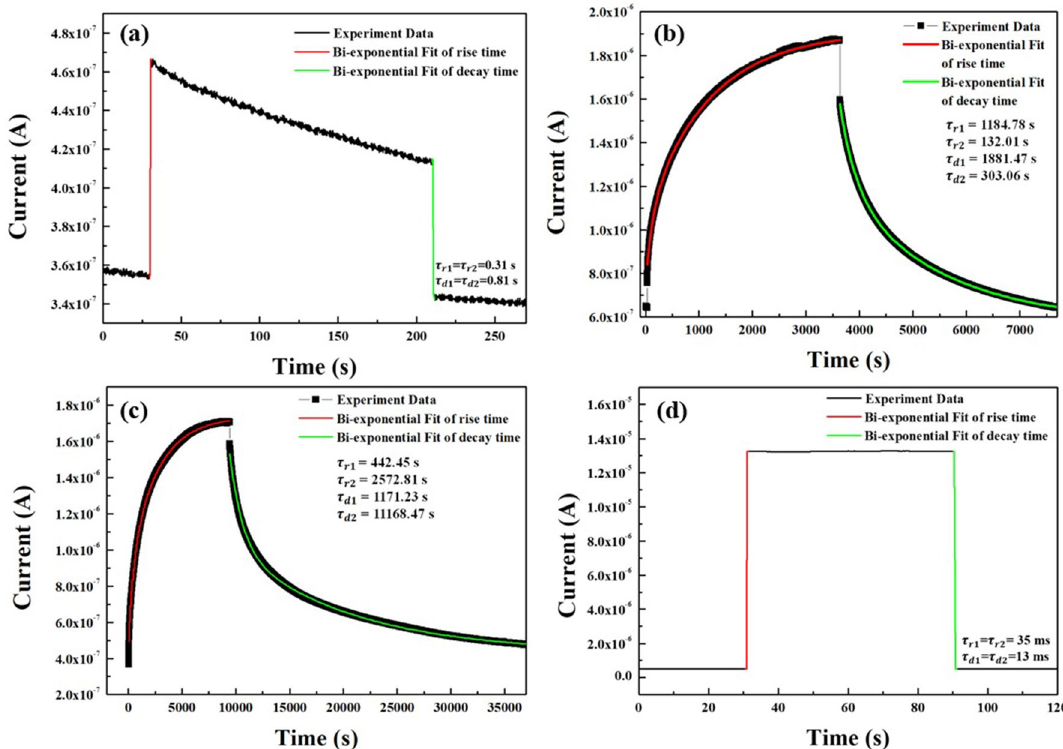
Figure 9. Rise and decay of photoresponse curves for (a) non-annealed ZnO thin films and annealed ZnO thin films by using (b) furnace, (c) IR lamp, and (d) TDA